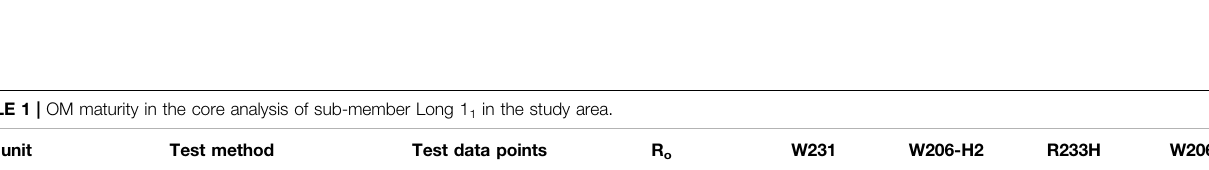
FIGURE 3 | Mineral composition in Wufeng Formation Long 1 1 sub-member in the study area. (A) . R233H. (B) . Well W206-H2. (C) . Brittle mineral content in the study area and adjacent areas.